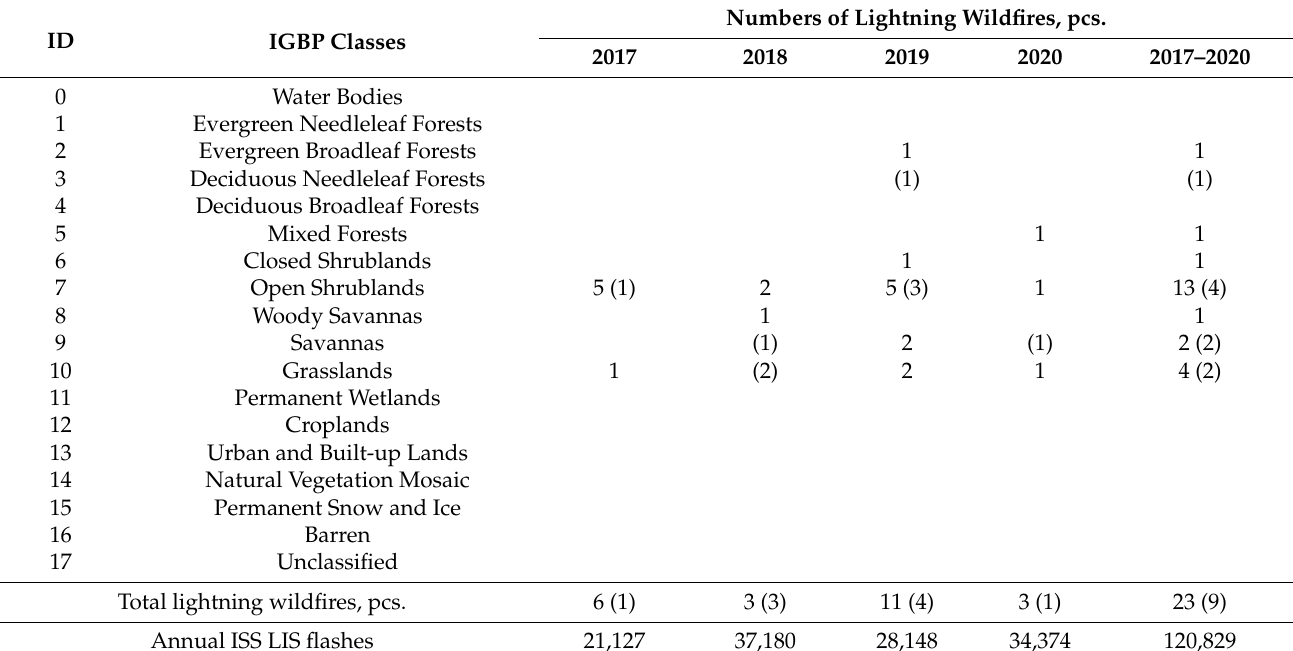
Table 4. Numbers of lightning wildfires in Australia in 2017–2020, occurring in the IGBP land cover vegetation classes. The values in brackets are related to events which did not complete the requirements for selection, specified in Section